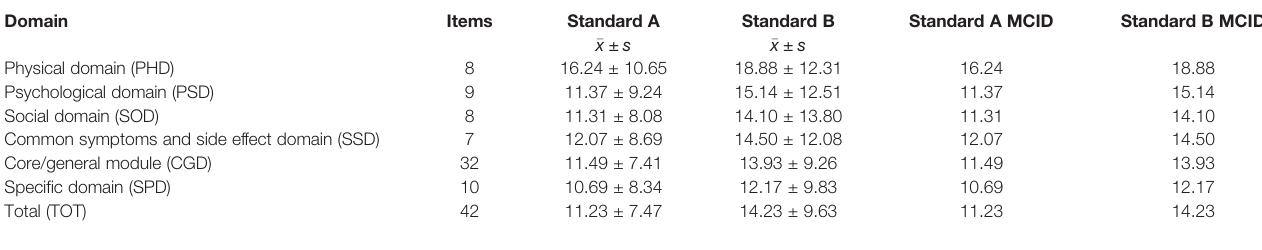
TABLE 3 | The MCID value of QLICP-BR (V2.0) determined by anchor-based method (n A = 116, n B = 166).